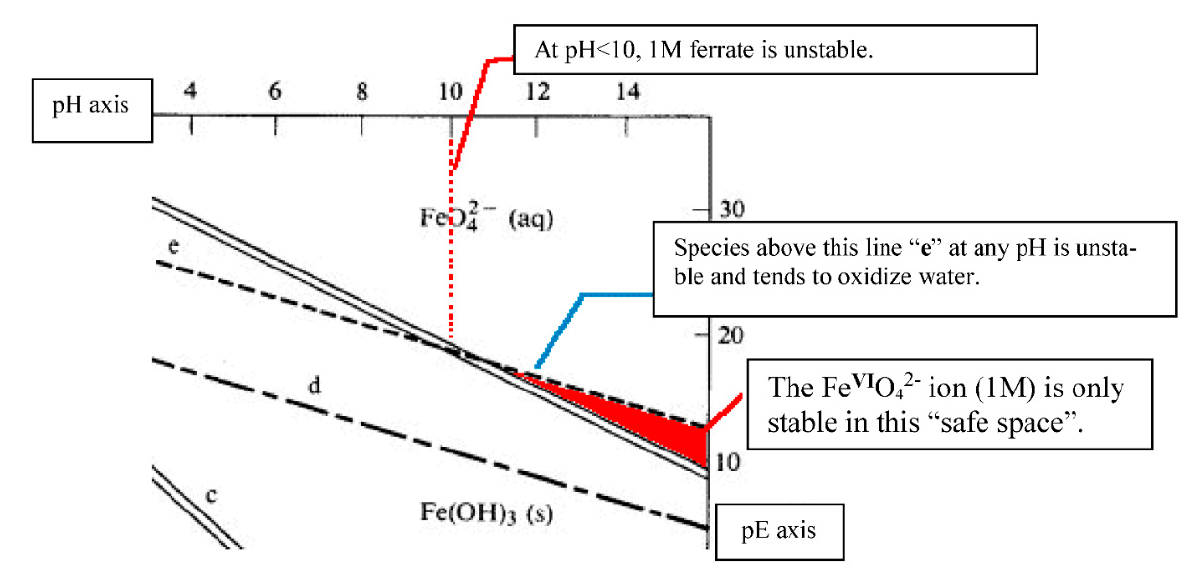
Figure 7. The ferrate (VI) stability region in aqueous solutions